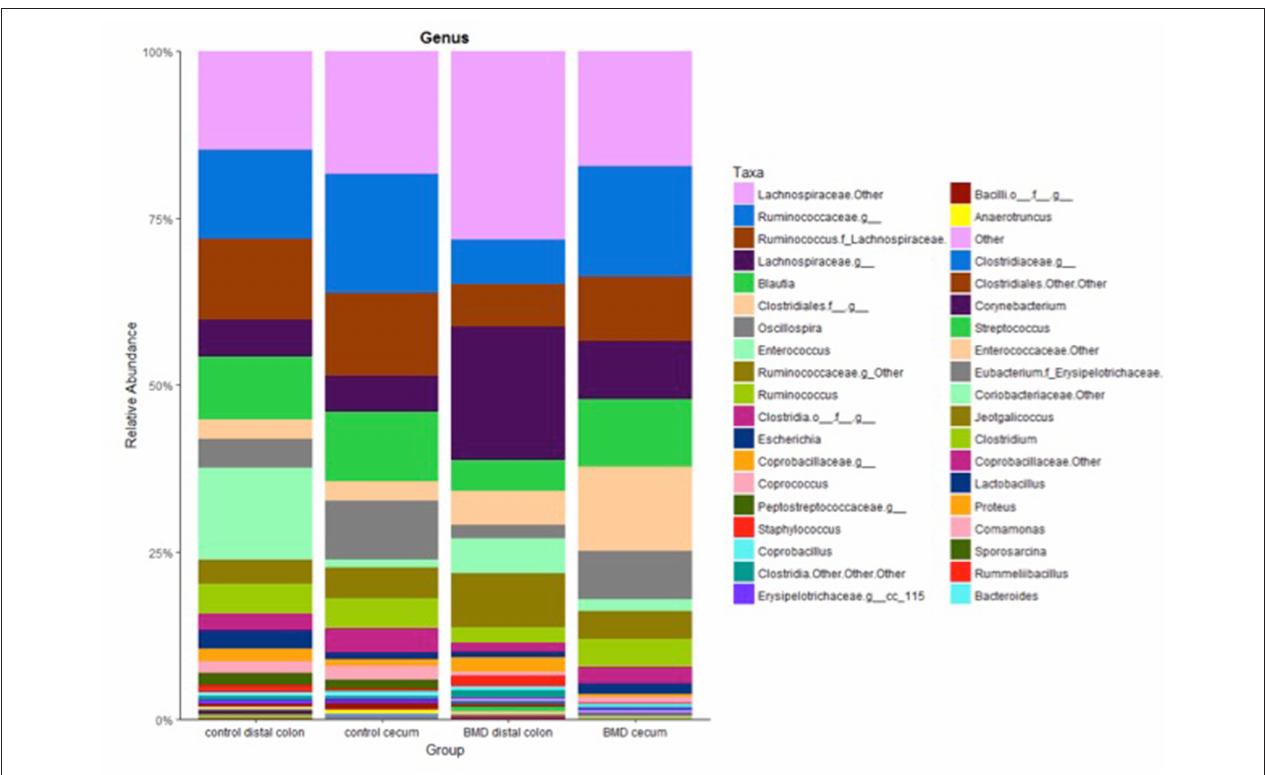
FIGURE 5 | Relative abundance at the genus level for each of the treatment groups. Specific genera are shown in the key on the